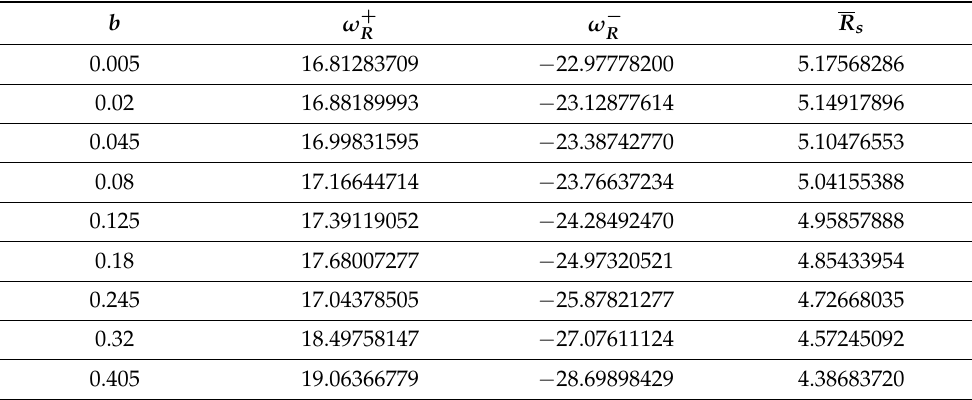
Table 1. shadow radius of KS black hole for different charge parameter b when a =